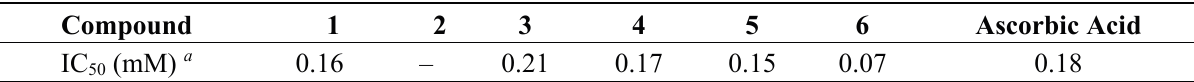
Table 1. 1,1-diphenyl-2-picrylhydrazyl (DPPH) radical scavenging activity of flavonoids isolated from the stems of Machilus japonica . a The IC 50 value of each compound was defined as the concentration (mM) that resulted in 50% DPPH scavenging activity. The results are averages of three independent